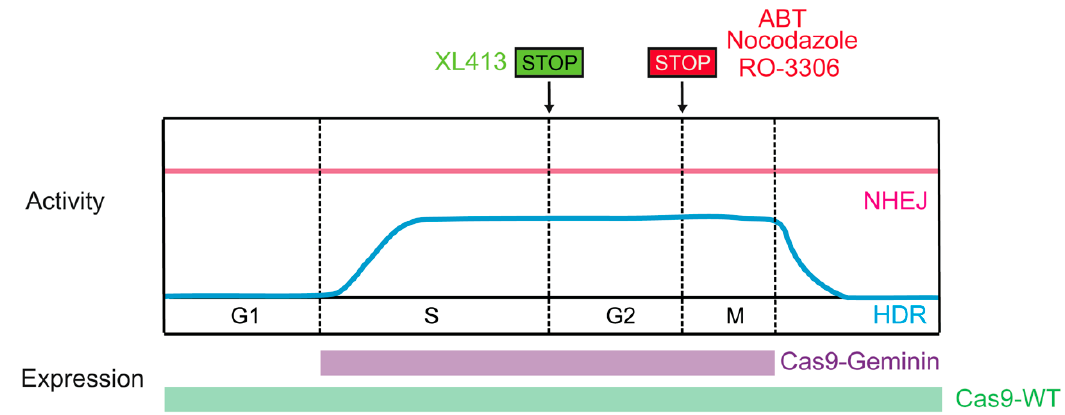
Figure 6. Methods restricting the Cas9-induced DSB to HDR-active cell cycle phases .